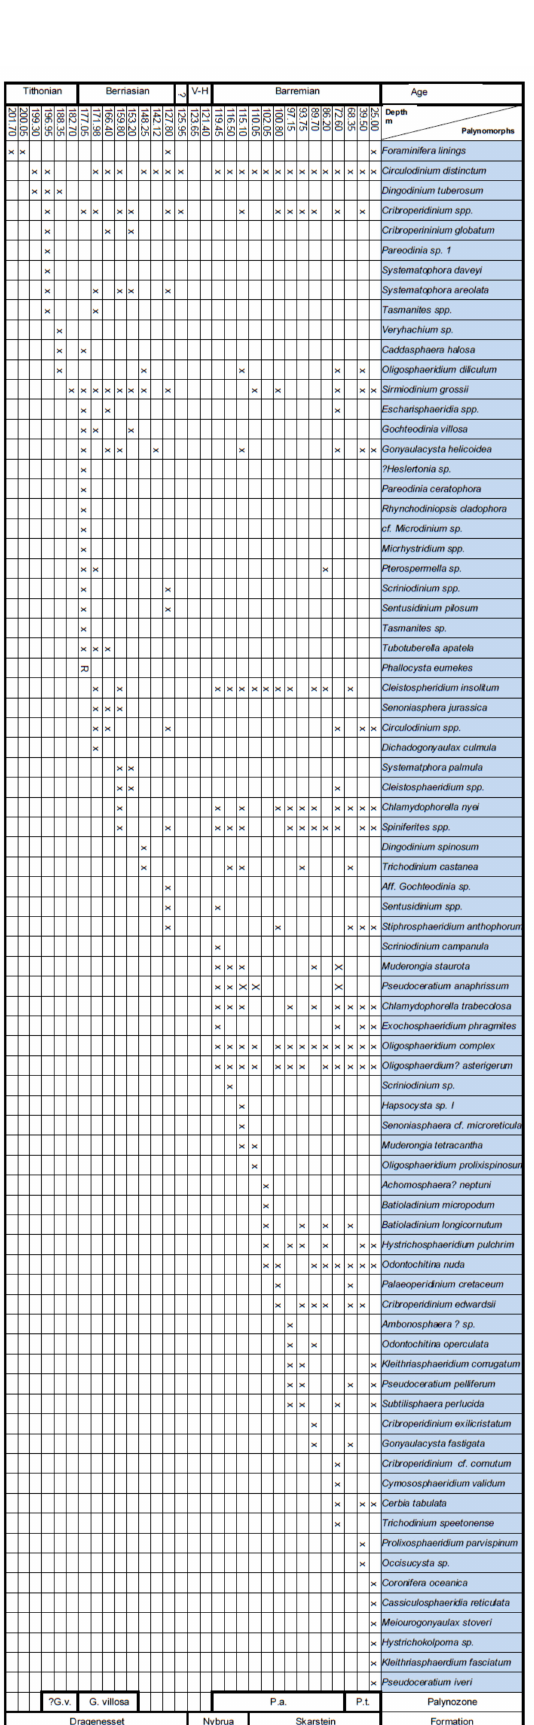
Figure A4. Records of marine palynomorphs in borehole Bh